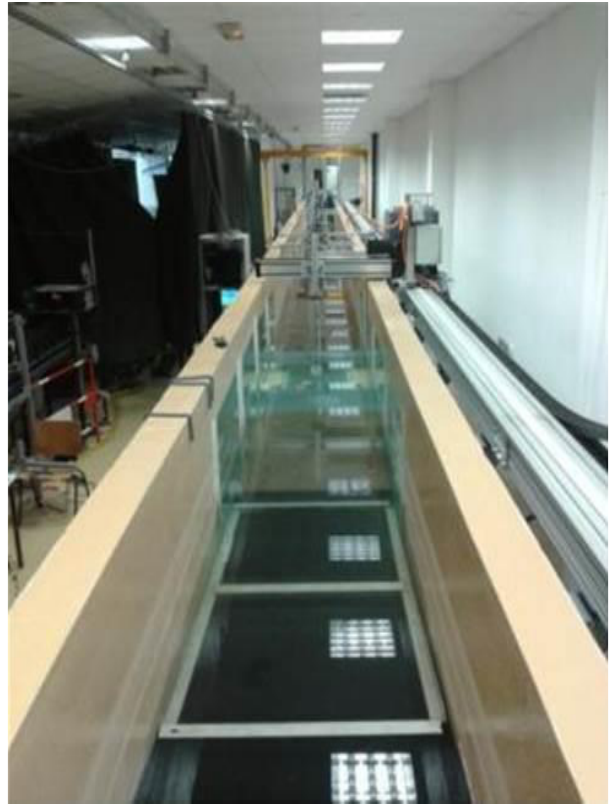
Figure 1. The wave flume.